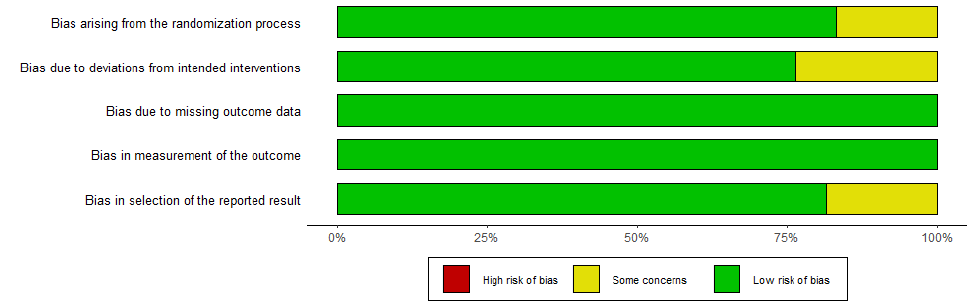
Figure 3. Assessment of the risk of bias using ROB-2 (traffic light figure).